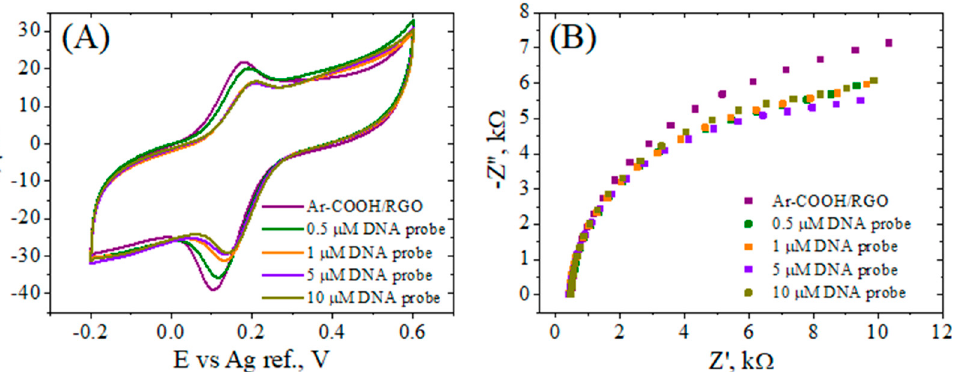
Figure 5. CV ( A ) and EIS Nyquist plot ( B ) recorded in 1 mM [Fe(CN) 6 ] 3 − /4 − , 0.1M KCl, for Ar– COOH/RGO/SPCE activated in EDC–NHS, and incubated with 0.5, 1, 5, and 10 µM amino–modified ssDNA probe.